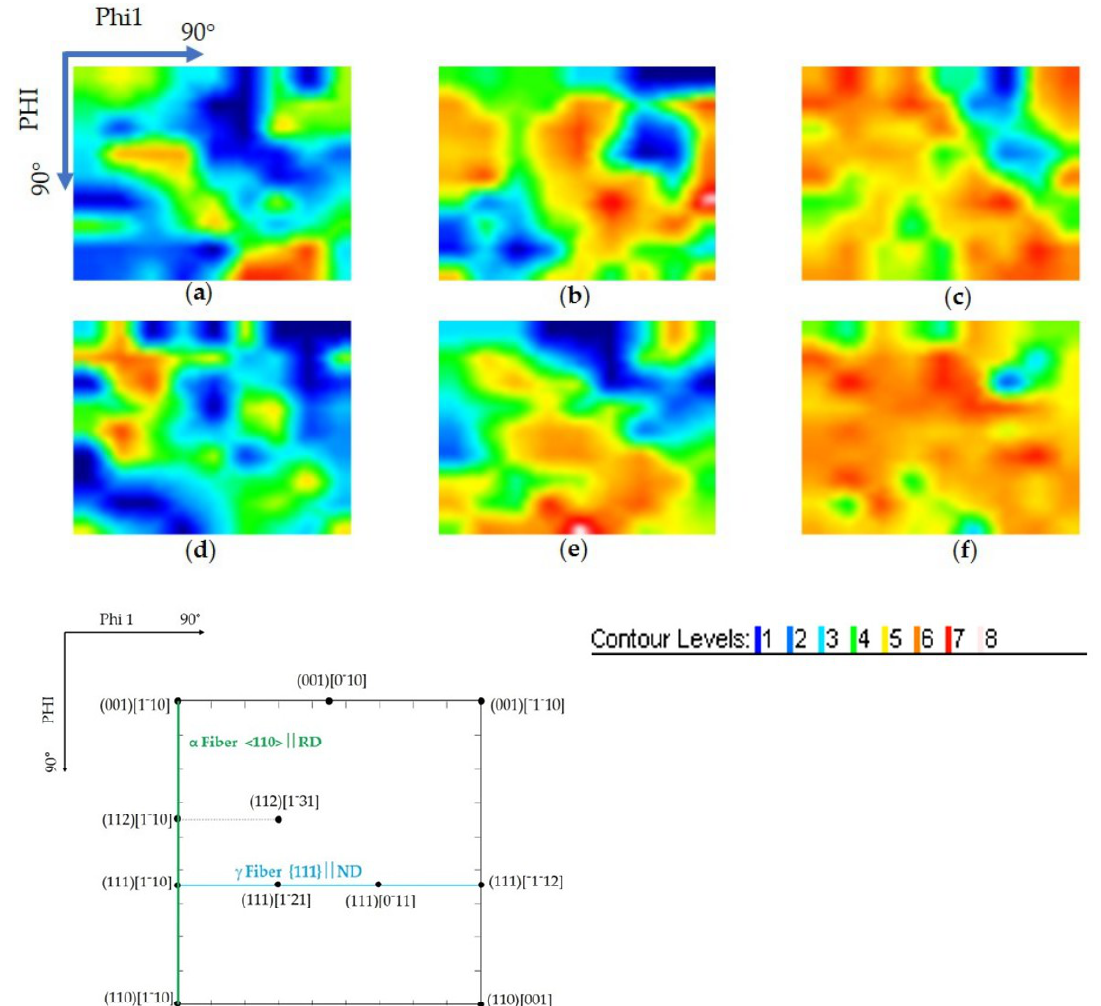
Figure 6. Texture components and fiber characteristics of a rolled plate in the orientation distribution function (ODF) sections of the Euler space of Phi2 = 45 ◦ at ( a ) 790 ◦ C, 1000:1000 rpm, ( b ) 830 ◦ C, 1000:1000 rpm, ( c ) 870 ◦ C, 1000:1000 rpm, ( d ) 790 ◦ C, 1500:1000 rpm, ( e ) 830 ◦ C, 1500:1000 rpm, ( f ) 870 ◦ C, 1500:1000 rpm according to the bcc production orientations in φ 2 = 45 ◦